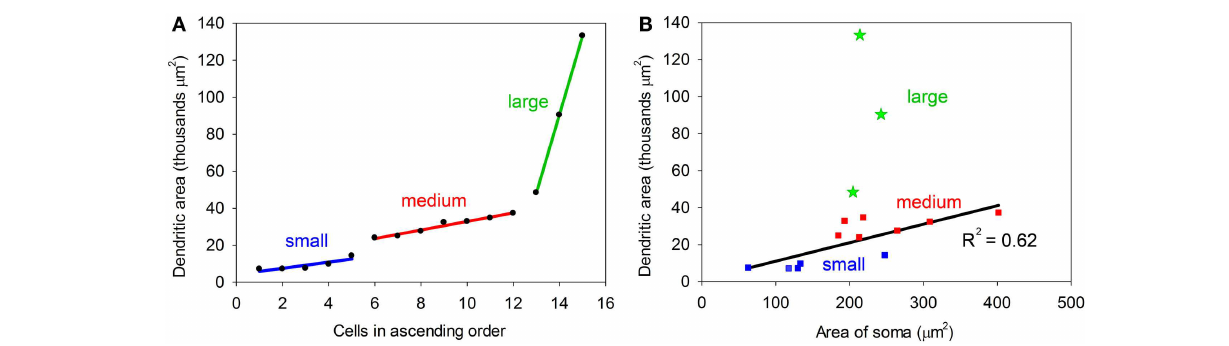
(B) Plot relating the area of the cell body to the area of the dendritic tree. For the small and medium cells there is a reasonably good correlation ( R 2 = 0.62), but for the large cells (green) the two values are not